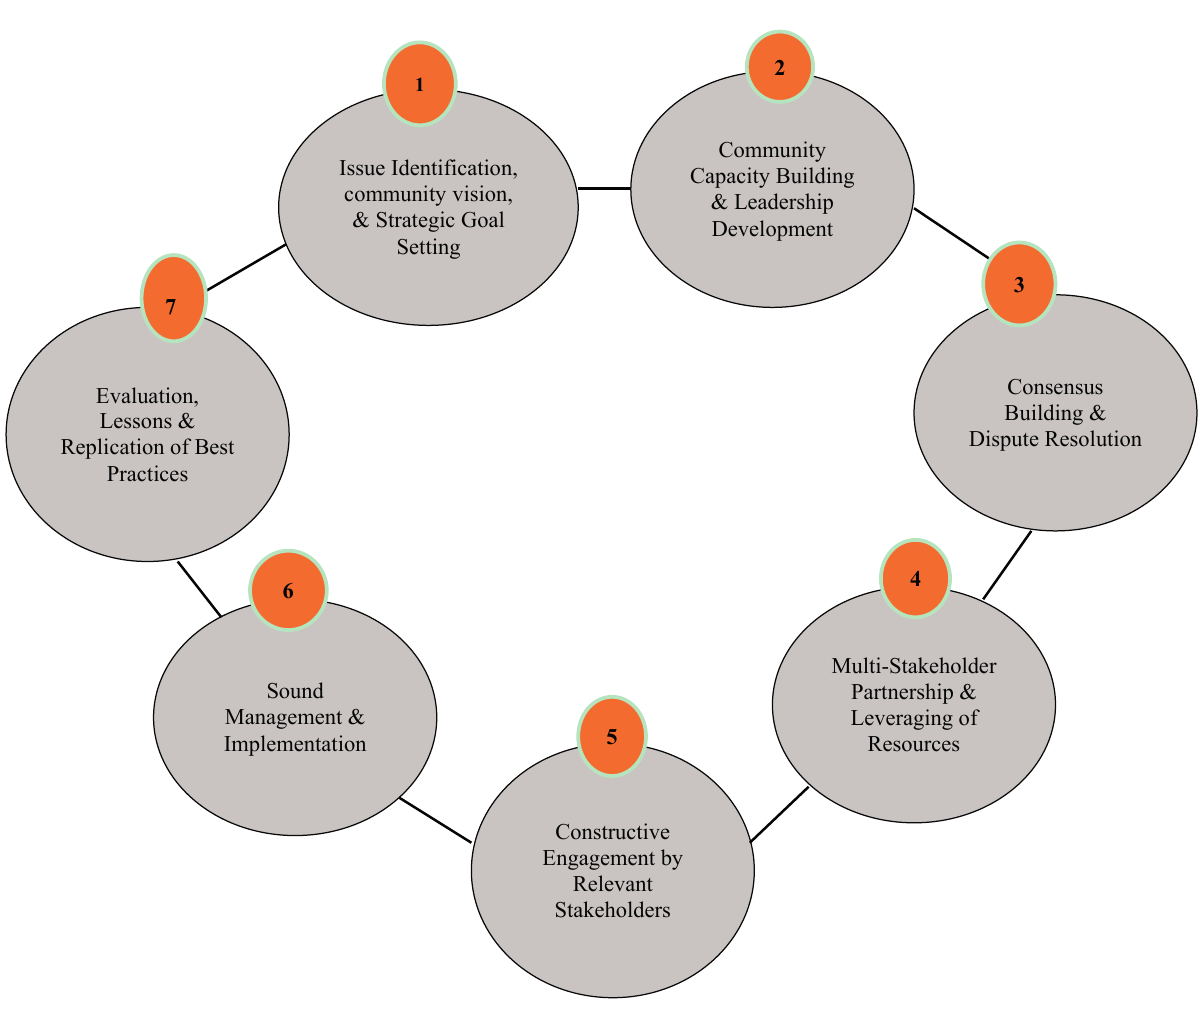
Figure 1. U.S. EPA collaborative problem—solving